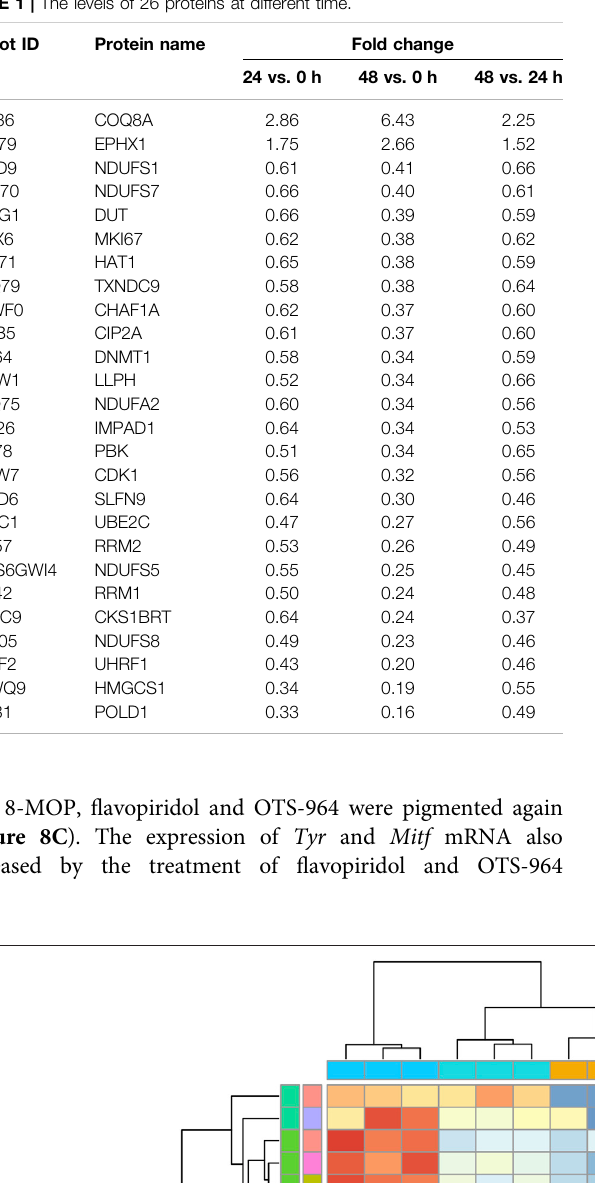
TABLE 1 | The levels of 26 proteins at different time.